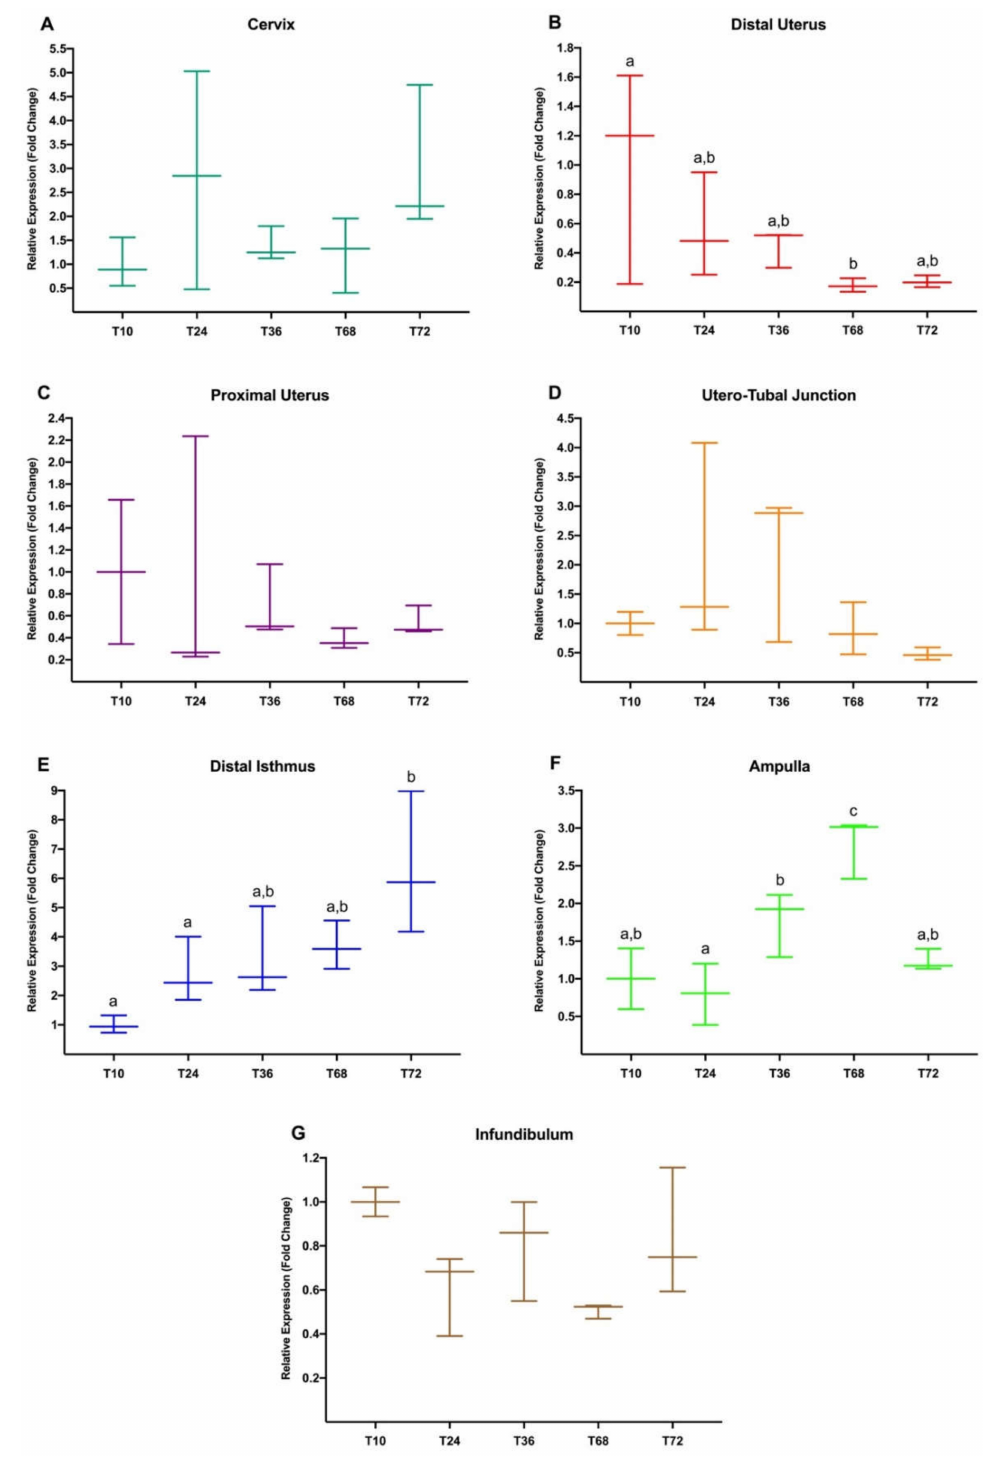
Figure 3. ( A – G ). NR3C1 gene expression di ff erences between each timepoint (T10, 10 h; T24, 24 h; T36, 36 h; T68, 68 h; and T72, 72 h; Experiment 2) post-natural mating in the di ff erent anatomical segments of the doe reproductive tract (cervix to infundibulum) ( A – G ). Di ff erent letters in the same anatomical region indicate values that di ff ered significantly between timepoints ( p < 0.05). The expression was relativized using the T10 as a reference. Median (minimum,